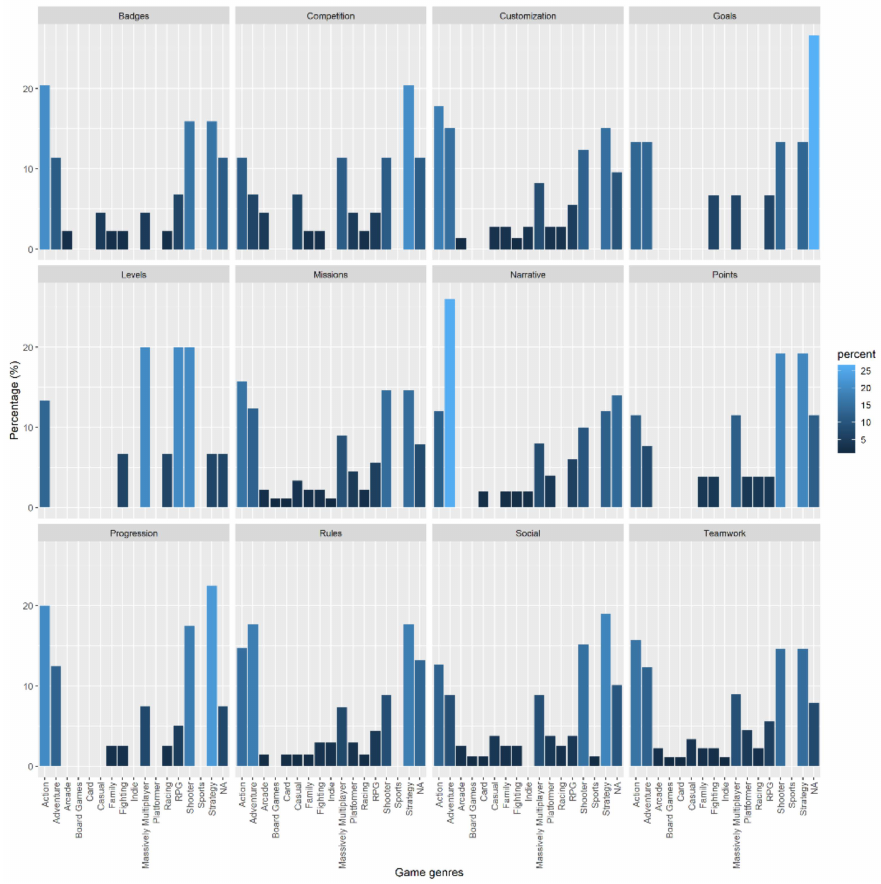
Figure 19. Bar chart showing the percentage of appearance of each game genre in each type of gamification element, a lighter color indicates a greater number of